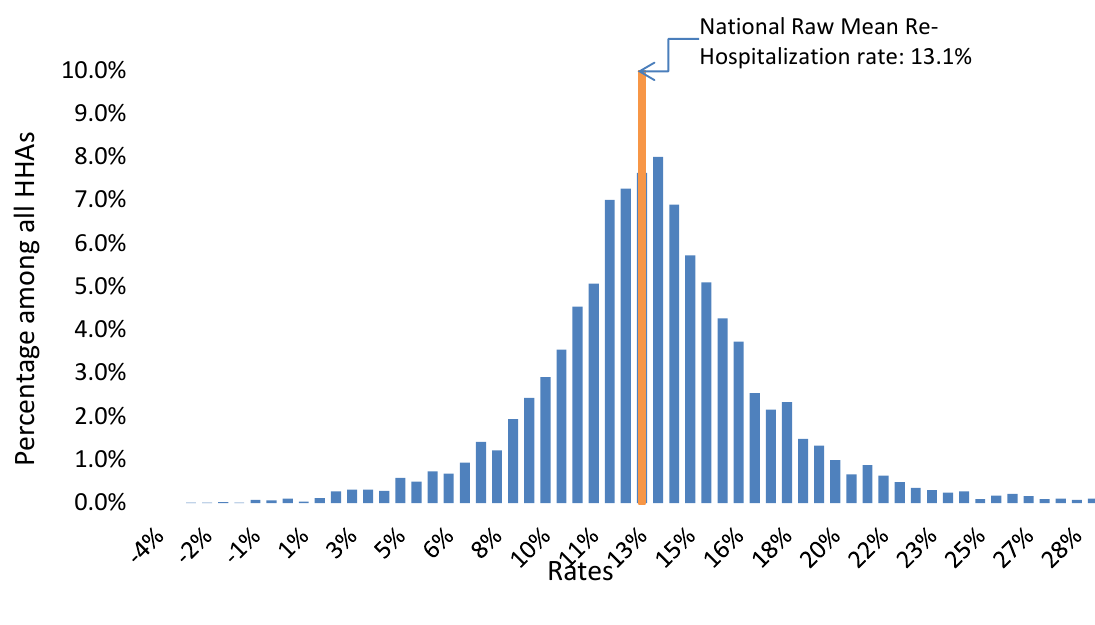
Figure 13.1: HHA 30-Day Re-Hospitalization Measure Performance, FYs 2012-2014